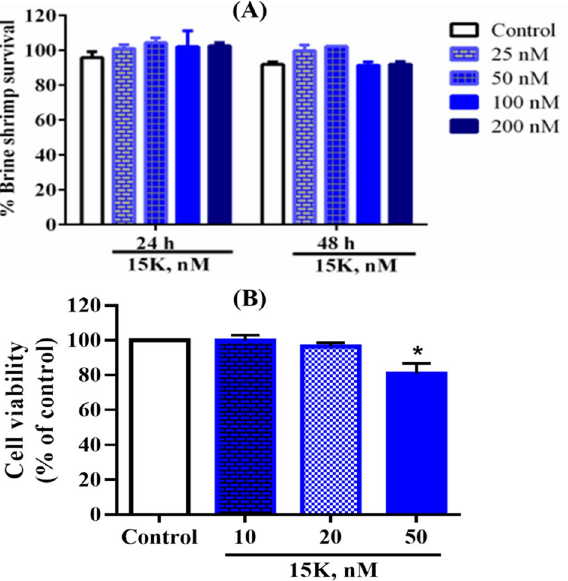
Figure 10. In vitro cytotoxic effects of 15K on brine shrimps ( A ) and 3T3L1 fibroblast cells ( B ) (* p < 0.05, control vs treatment).